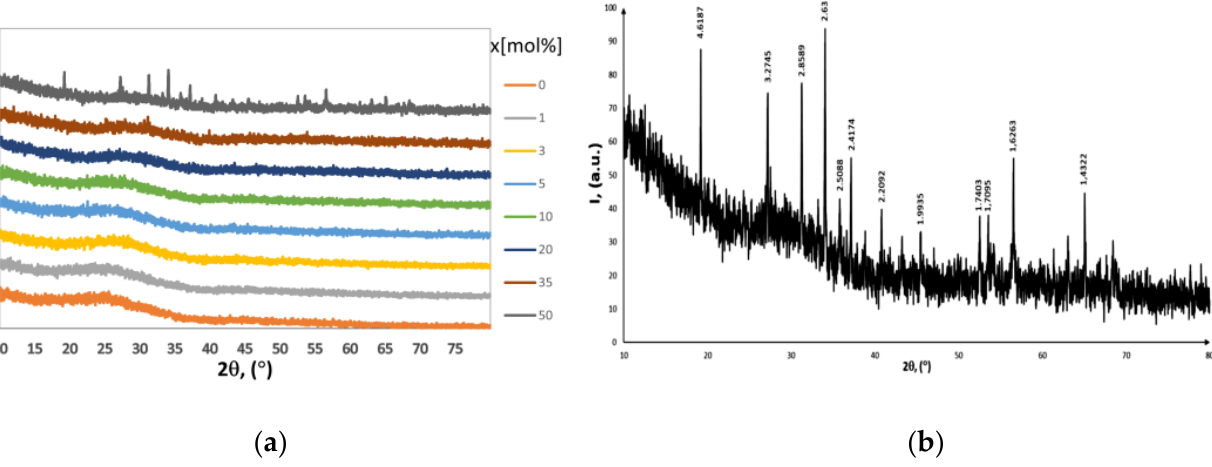
Figure 1. ( a ) The XRD patterns of x(Fe 2 O 3 · V 2 O 5 ) · (100 − x)[P 2 O 5 · CaO] glasses systems (0 ≤ x ≤ 50 mol%), ( b ) The XRD pattern of x(Fe 2 O 3 · V 2 O 5 ) · (100 − x)[P 2 O 5 · CaO] for x = 50%mol, normalized to maximum.